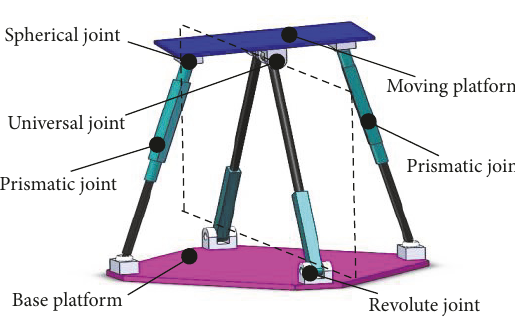
Figure 1: CAD model of the proposed 4-DOF SPM 2-RPU&2-SPS.